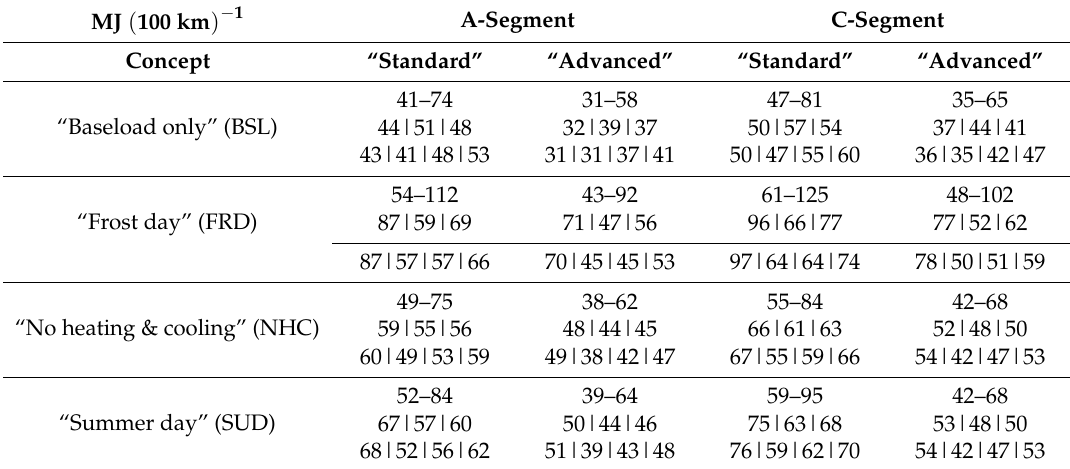
Table A6. Fuel economy figures of BEVs considering different load cases and drive cycles. First line: Range of results for all 25 drive cycles. Second line: Values for ECE|EUDC|MVEG; Third line: Values for WLTC-Low|WLTC-Middle|WLTC-High|WLTC-Very high.